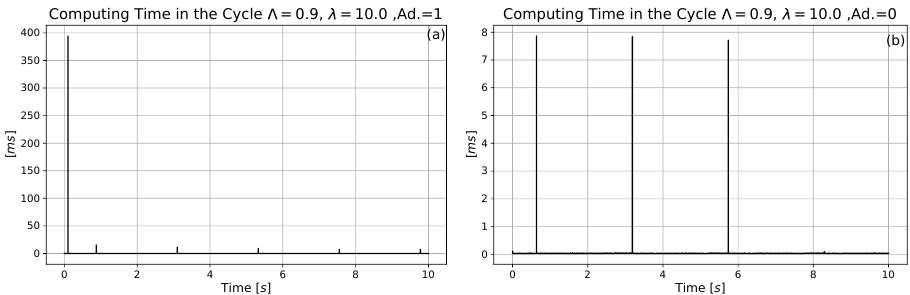
Figure 17. The computational time of the control cycles. ( a ): Adaptive. ( b ): Non-adaptive.